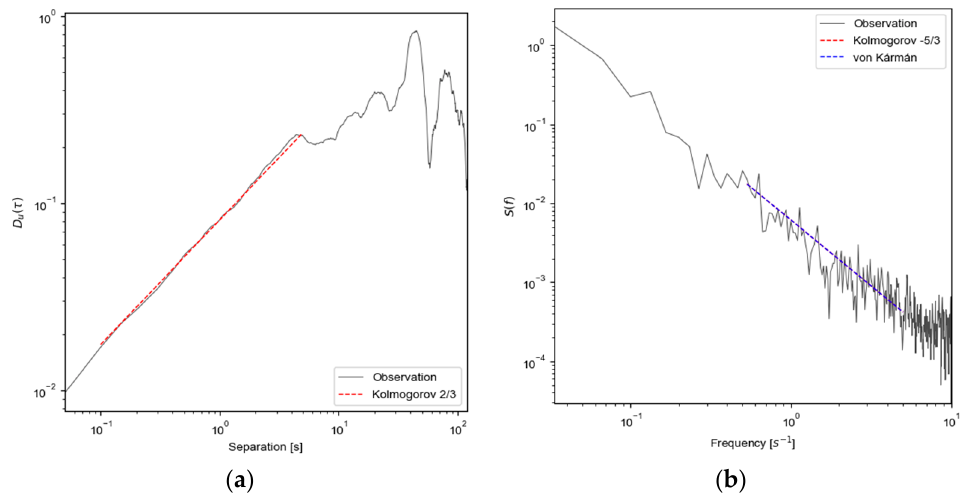
Figure 4. SFs and PSDs of EDR at 60 m at 18:00 25 October 2018 LST. The length of the red and blue lines indicate the IR range used in the calculation. ( a ) (black) the observed SF from the anemometer and (red) the theoretical SF expected for Table 1. (0.2169 m 2/3 s − 1 ) by Kolmogorov turbulence hypothesis; ( b ) (black) the observed PSD from the anemometer, (red) the theoretical PSD expected for the estimated EDR2 (0.2113 m 2/3 s − 1 ) by the Kolmogorov turbulence hypothesis, and (blue) the theoretical PSD for the estimated EDR3 (0.2978 m 2/3 s − 1 ) by the von Kármán spectral model. Note that the red and blue lines in ( b ) are closely overlapped.